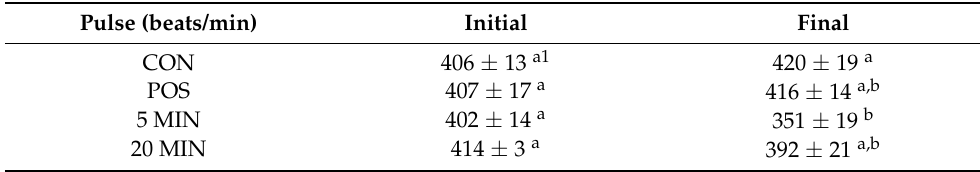
Table 4. Pulse assessment using the tail-cuff method in rats. Pulse (beats/min) Initial Final CON 406 ± 13 a1 420 ± 19 a POS 407 ± 17